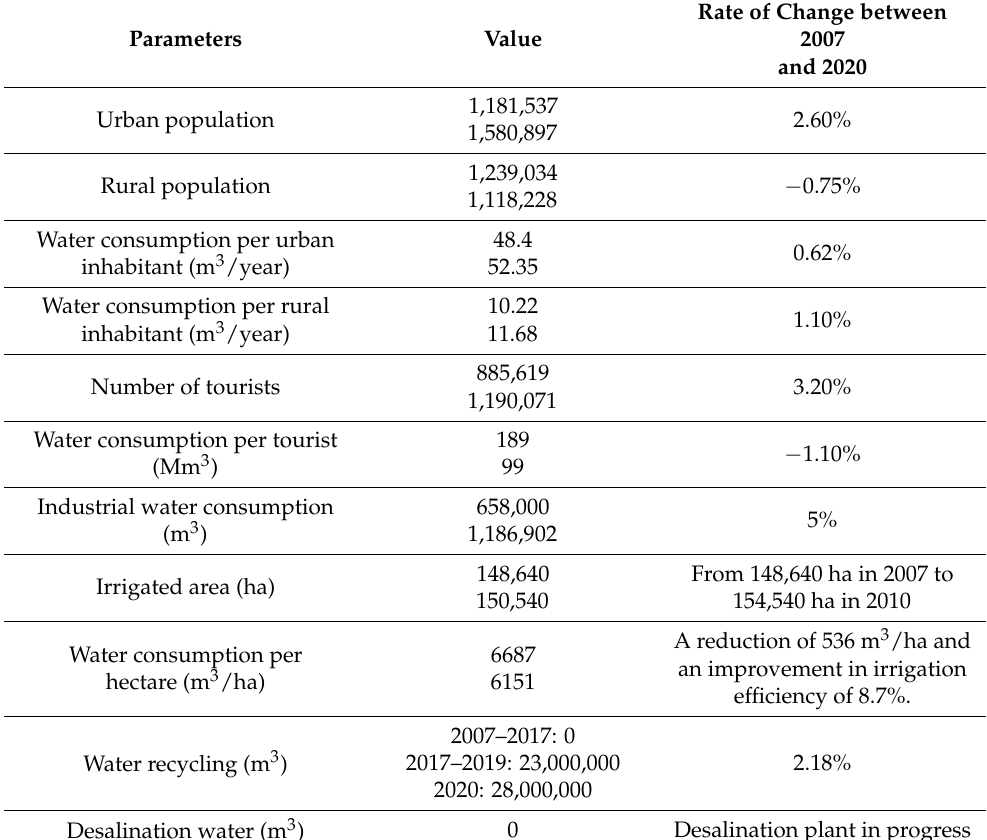
Table 3. Range of variation of the System Dynamics model